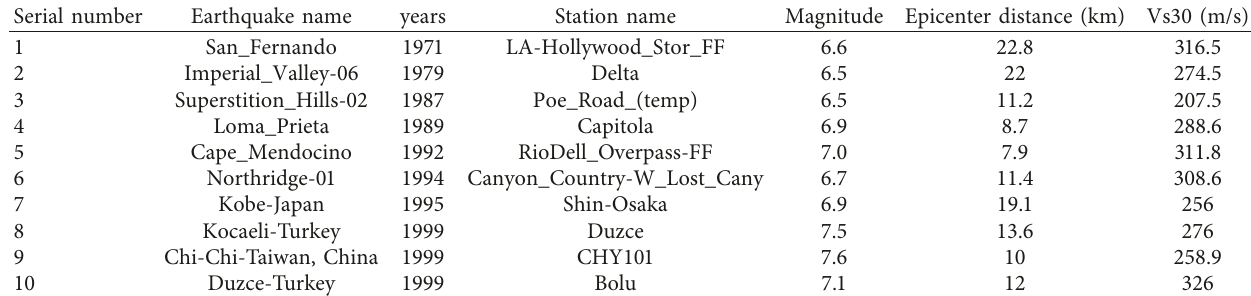
Figure 10: The layout of CRAD-VD: (a) 1–3-floor CRAD-VD layout; (b) 4-floor CRAD-VD layout; (c) 5–10-floor CRAD-VD layout. Table 2: Information of seismic